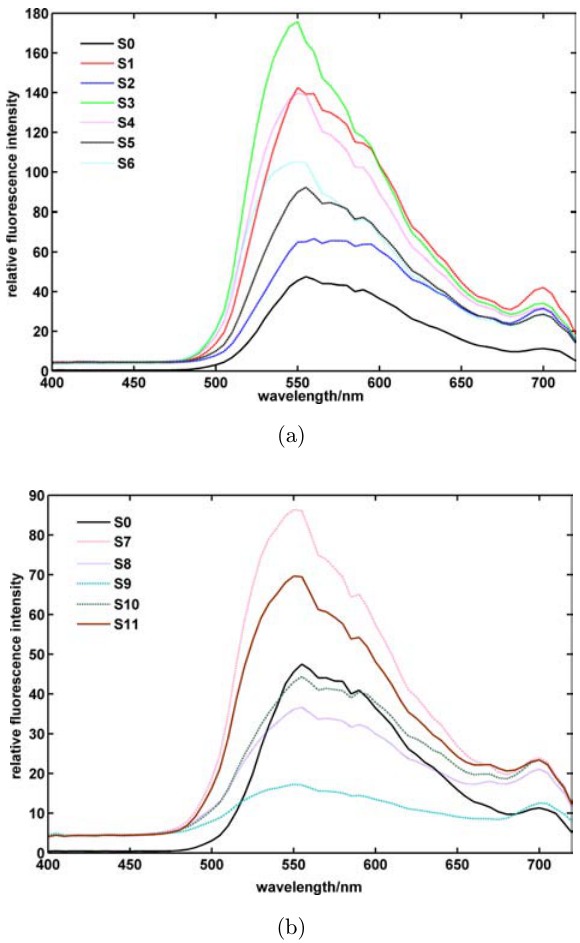
Fig. 8. (a) The °uorescence comparison between di®erent kinds of BH tablets/capsules; (b) the °uorescence comparison between di®erent kinds of